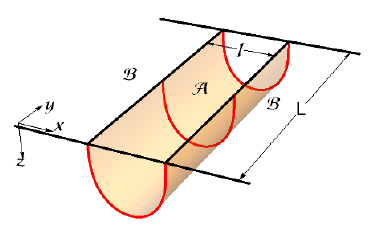
Figure 1 . The pro(cid:12)le of the minimal surface of an in(cid:12)nite strip in pure AdS